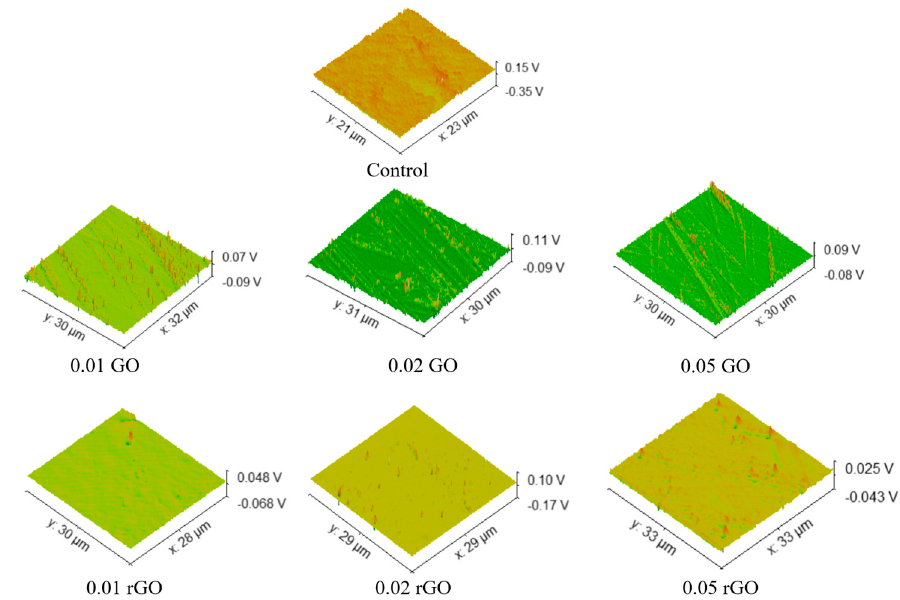
Figure 13. AFM images of the